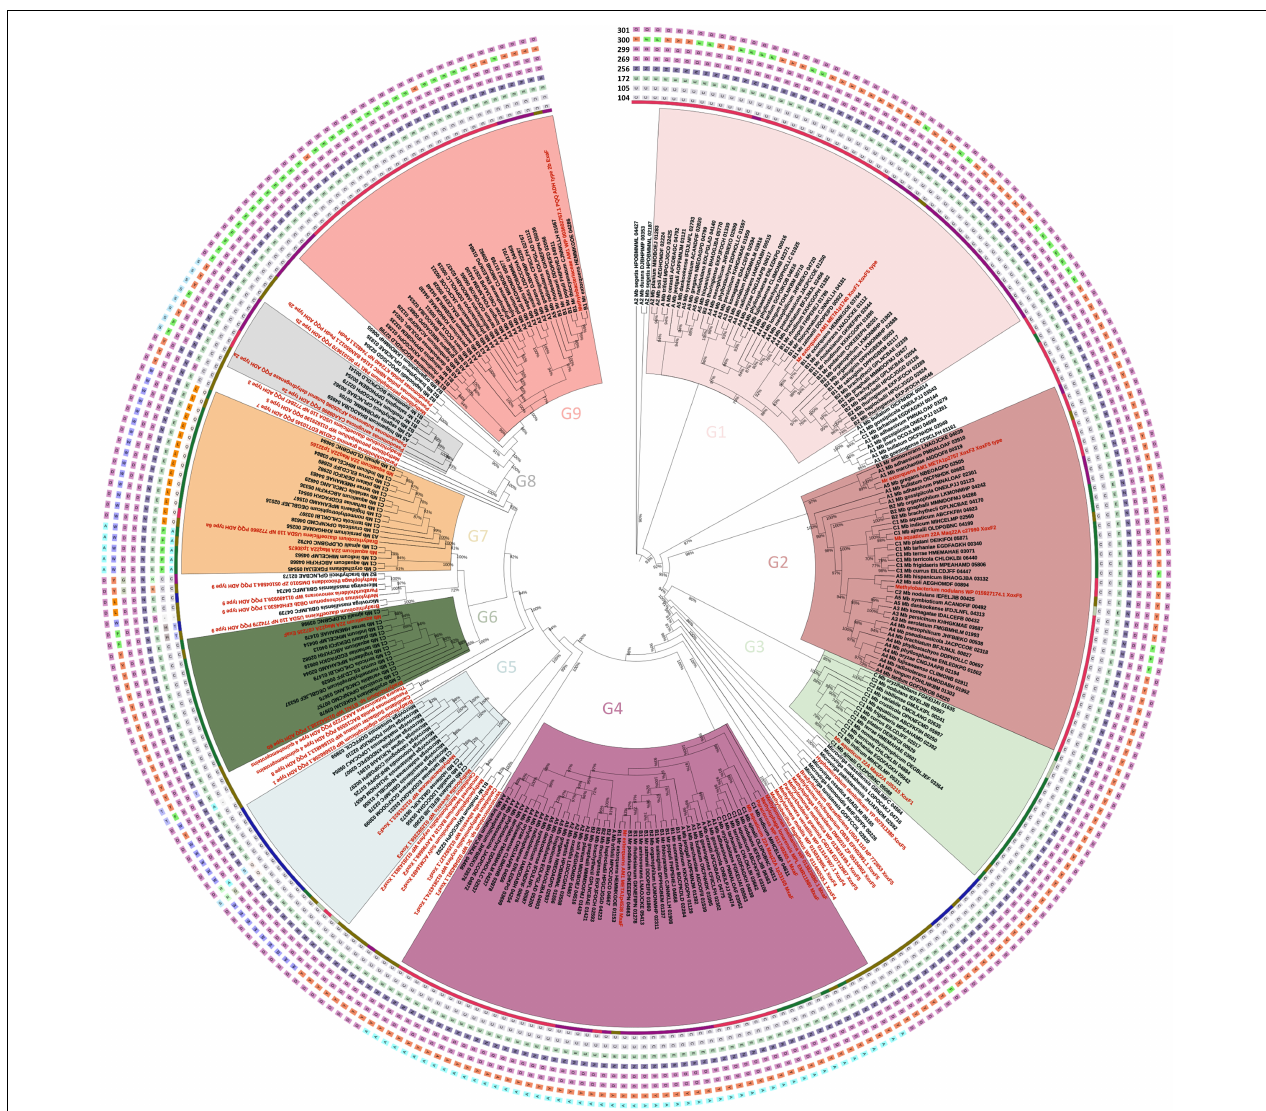
FIGURE 5 | Maximum likelihood phylogeny of PQQ-ADH homologs found in Methylobacteriaceae genomes. The tree was built based on the alignment of 252 homologs and 49 reference sequences. The tree was created with FastTree v2.1, and the local support values ( > 0.7) on the branches shown as a percentage. The reference sequences are shown in red. The highlighted clades labeled G1–G9 represent the following groups: G1, XoxF5-type MDH (XoxF1 in AM1); G2, XoxF5-type MDH (XoxF2 in AM1); G3, XoxF5-type MDH (XoxF1 in 22A); G4, MxaF-type MDH; G5, XoxF3-type MDH; G6, ExaF-type ADH (ExaF in 22A); G7, PQQ-ADH type 6a; G8, PQQ-ADH type 2a; and G9, PQQ-ADH type 2b (ExaF in AM1). The inner colored circle around the tree indicates different PPFM clades (A,B,B2,C,C1, and C2, same as Figure 2 ) and Microvirga species (blue). The outer circles indicate different amino acid residues that are important for the coordination of metals (Ca 2 + or Ln 3 + ) in the active sites of PQQ-ADHs. Each abbreviation of amino acid is shown in a different colored box. The positions of amino acid residues corresponding to the mature XoxF from Methylacidiphilum fumariolicum SolV (C104, C105, E172, N256, D269, D299, Y300, and D301) are presented in the outer circles from the inside to the outside in that